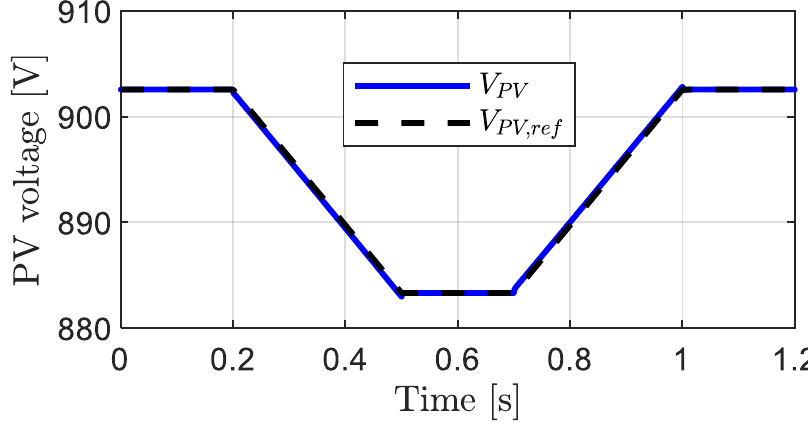
Figure 5. PV voltage time profile.